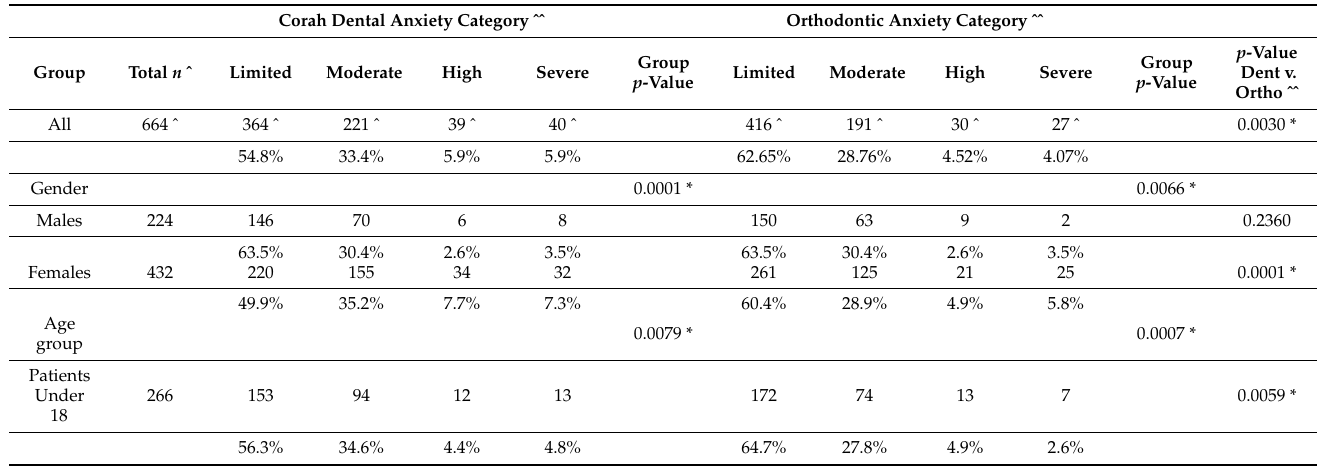
Table 4. Corah Dental and Orthodontic Modified Dental Anxiety Scales by group